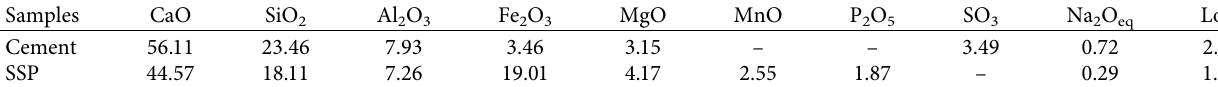
Table 1: Chemical compositions of the cement and SSP (%).